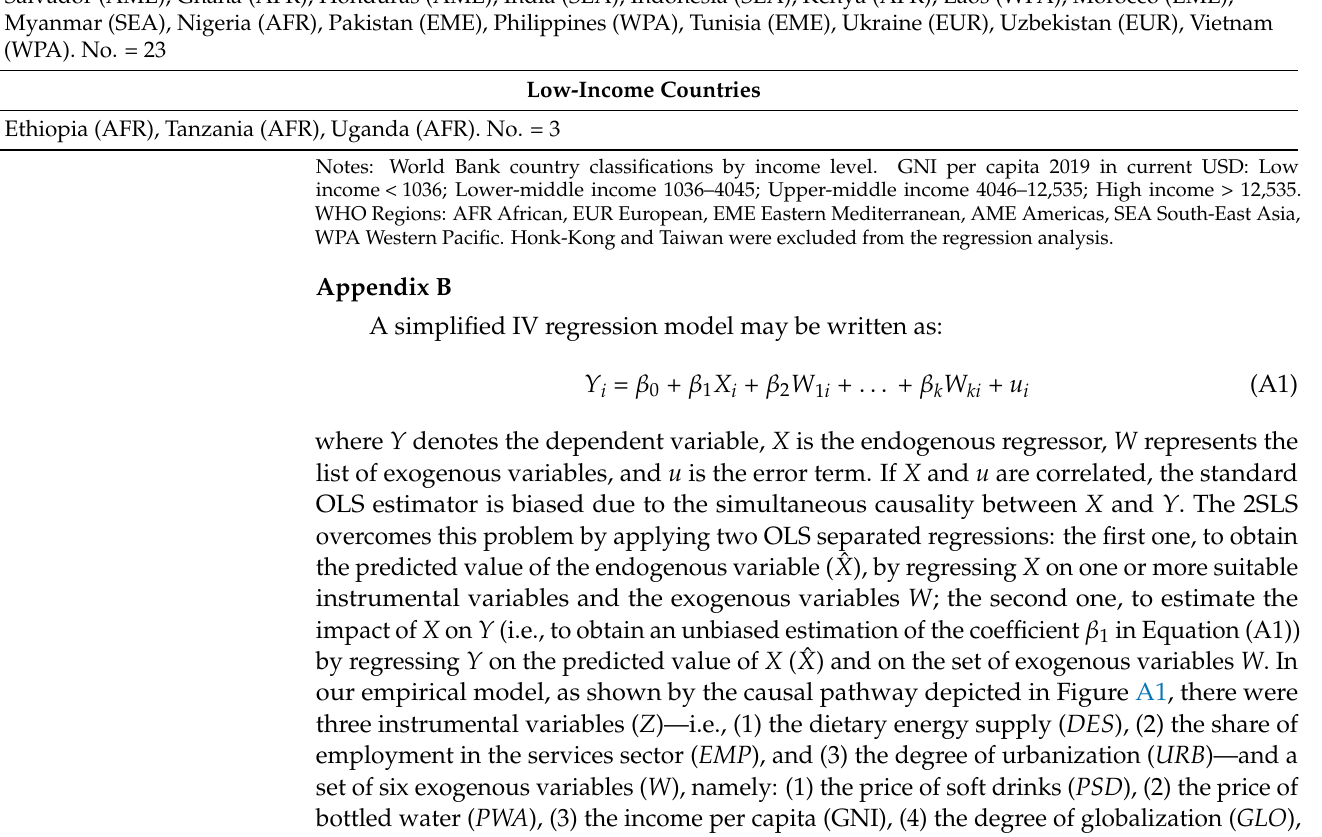
Table A1. Cont. Lower-Middle Income Countries Angola (AFR), Bangladesh (SEA), Bolivia (AME), Cambodia (WPA), Cameroon (AFR), C ô te d’Ivoire (AFR), Egypt (EME), El